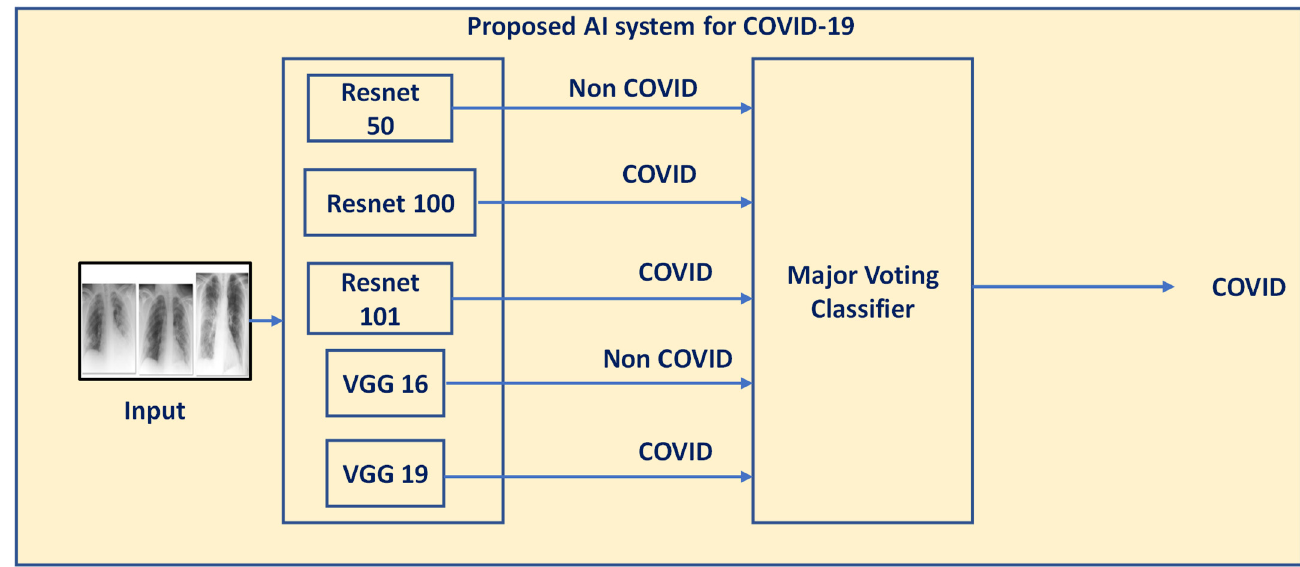
Figure 8. Working Principle of Major Voting Classifier.